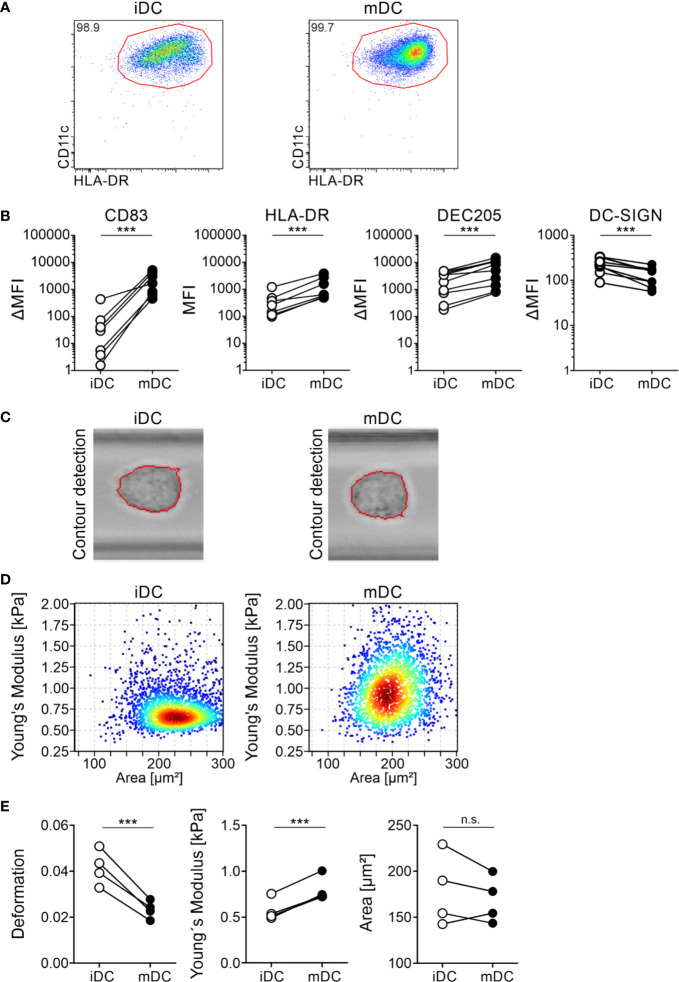
Differential protein surface expression and cell mechanics of immature and mature moDCs. moDCs were generated from monocytes of healthy donors within seven days in cell culture in the presence of GM-CSF and IL-4. On day 6 half of the cells were activated using a maturation cocktail consisting of PGE2, TNFα, IL-1β, and IL-6. On day 7 immature (iDC) and mature (mDC) moDCs were harvested and 5 × 105 cells were stained for FACS analysis with the antibodies CD11c-PE/Cy7 (1:100), HLA-DR-BV605 (1:100), CD83-A647 (1:100), and CD86-PE (1:100), or respective isotype controls. Cells were recorded using BD LSRFortessa and analyzed using FlowJo software. (A) Gating of double positive CD11c+HLA-DR+ immature and mature moDCs. Depicted is the gating of one representative donor. (B) Paired scatter plots of expression of activation markers CD83 and HLA-DR on immature and mature moDCs as well as the DC markers DEC205 and DC-SIGN. Median fluorescence intensity ΔMFI results of the MFI of antibodies against CLRs minus MFI of the corresponding isotype controls. Statistical significances were calculated using paired t-test (n≥10). Not significant (n.s.) p>0.05, *p<0.05, **p ≤ 0.01, ***p ≤ 0.001. (C–E) Real-time fluorescence deformability cytometry of immature (iDC) and mature (mDC) moDCs. moDCs were generated as described before. On day 7, immature and mature moDCs were harvested and 1 × 106 cells were stained for real-time fluorescence deformability cytometry analysis with the antibodies CD83-PE (1:100) and HLA-DR-FITC (1:50). Real-time fluorescence deformability cytometry of immature and mature moDCs from one representative donor (n = 4). (C) Phase-contrast images of one representative immature and mature cell with contour detection showing deformation of moDCs. (D) Young’s modulus with (elastic modulus E) of immature and mature moDCs of the same representative donor as in (C). (E) Paired scatter plots of deformation, Young’s modulus and cell size (area) of all donors. Statistical significances were calculated using linear mixed model (n = 4). Not significant (n.s.) p>0.05, *p<0.05, **p ≤ 0.01, ***p ≤ 0.001.